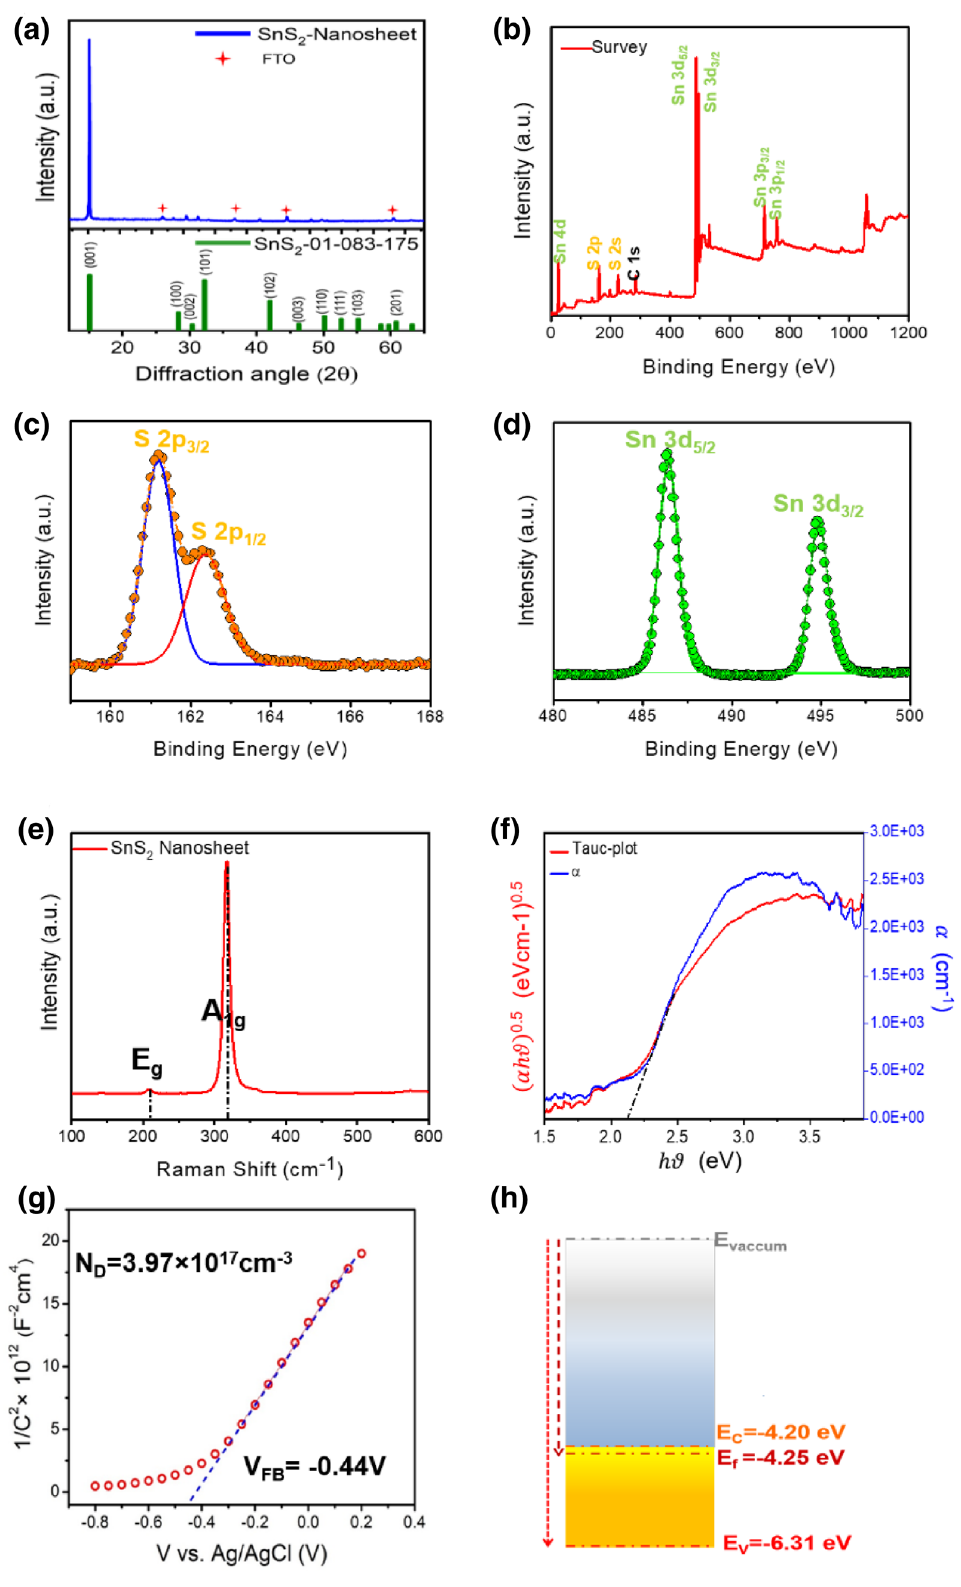
Figure 2. Crystal structure and optical properties of SnS 2 nanosheet. ( a ) XRD pattern. ( b ) Full XPS spectra, ( c ) S 2p and ( d ) Sn 3d peaks of grown vertically SnS 2 nanosheet on FTO, ( e ) The Raman spectra ( f ) Absorption evolution versus energy and Tauc plot of vertically grown SnS 2 nanosheet on the FTO. ( g ) The Mott–Schottky analysis of vertically SnS 2 nanosheets grown on FTO substrate in the 1 M aqueous Na 2 SO 4 at f = 1 kHz, ( h ) The calculated energy levels of